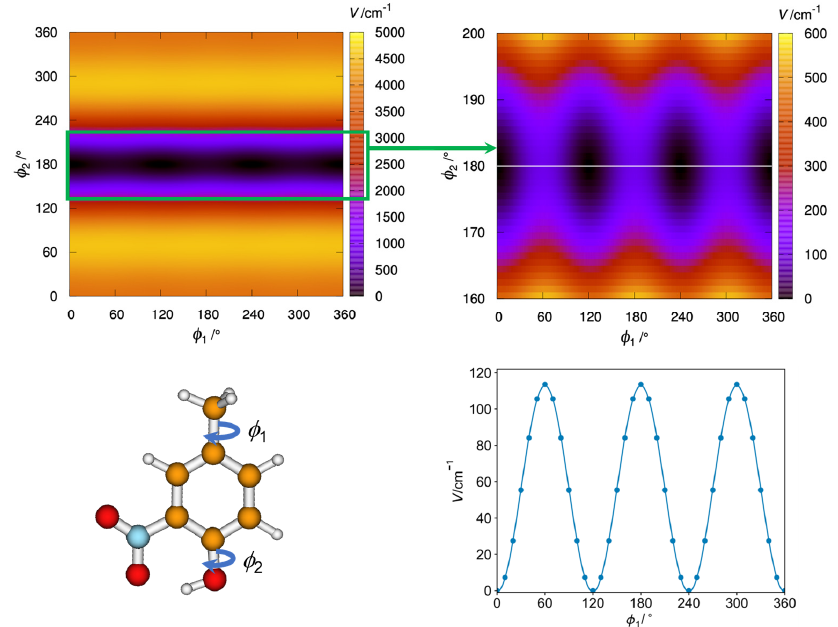
Figure 2. ( Top left ): Contour plot showing the variation of potential energy (in cm − 1 ) with the internal rotation of the methyl ( φ 1 ) and hydroxyl ( φ 2 ) groups of 4MNP ( bottom left ). A zoom of the contour plot enhancing the region of the absolute minima is depicted in the ( top right ) position. A one-dimensional cut (white line in the zoomed contour plot) that passes through the equilibrium structures shows the fit of the V 3 potential to the B3PW91 points ( bottom right ).